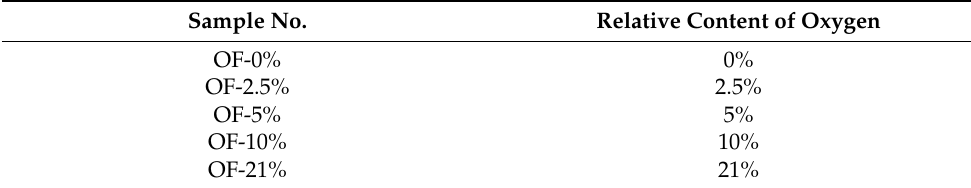
Table 1. Prepared pre-oxidized fiber with different oxygen content, marked as OF. Sample No. Relative Content of Oxygen OF-0% 0%